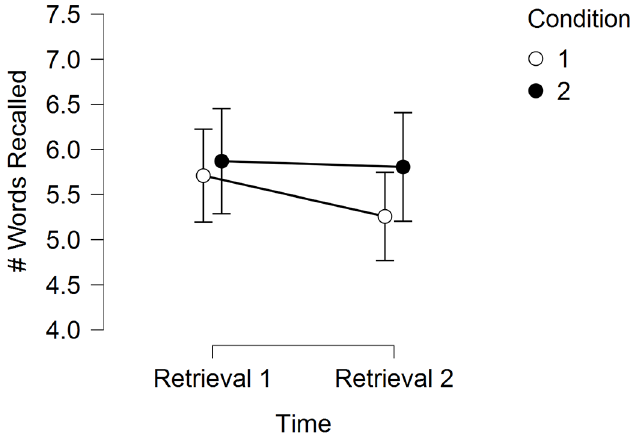
Note . Error bars are standard